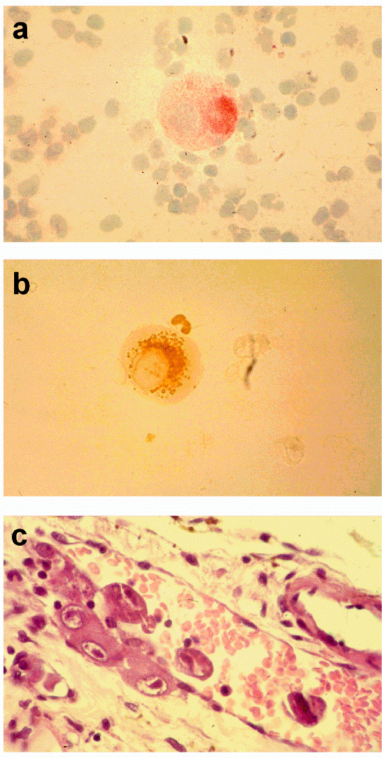
Figure 1. Circulating cytomegalic endothelial cells stained with: ( a ) the endothelial cell-specific PAL-E monoclonal antibody; ( b ) a pp65-specific human cytomegalovirus (HCMV) monoclonal antibody (a pp65-positive polymorphonuclear leukocyte is shown in close proximity). ( c ) Several cytomegalic endothelial cells are present along the vessel wall and in the bloodstream of a prostatic vessel of an AIDS patient with disseminated HCMV infection (from